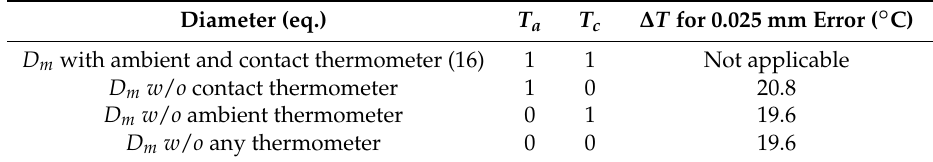
Table 3. Cases if one or both of the temperature probes are not available. “1” means that the temperature data are available, “0” means that the temperature data are not available. Diameter (eq.)